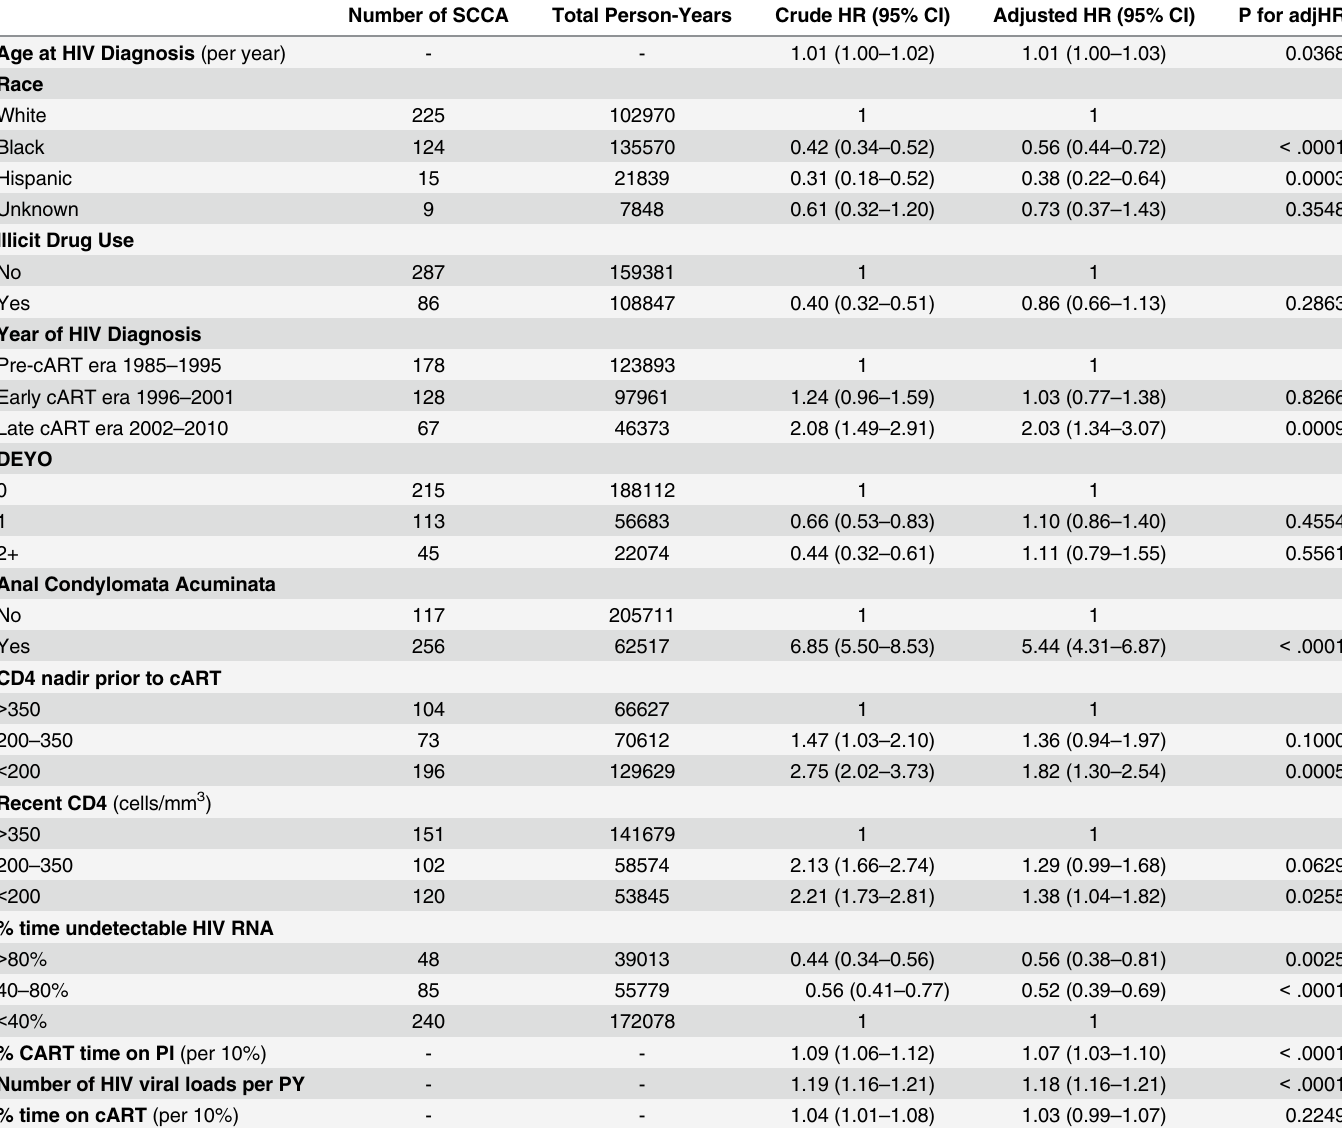
Table 2. Regression Analysis – Association between Protease Inhibitors (with Percent Time on cART and Percent Time Undetectable HIV RNA) & Time to Development of Squamous Cell Carcinoma of the Anus. Number of